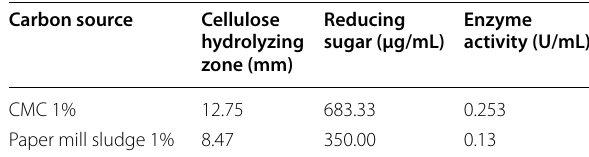
Table 1 Screening for cellulase activities and reducing sugar yields of the strain